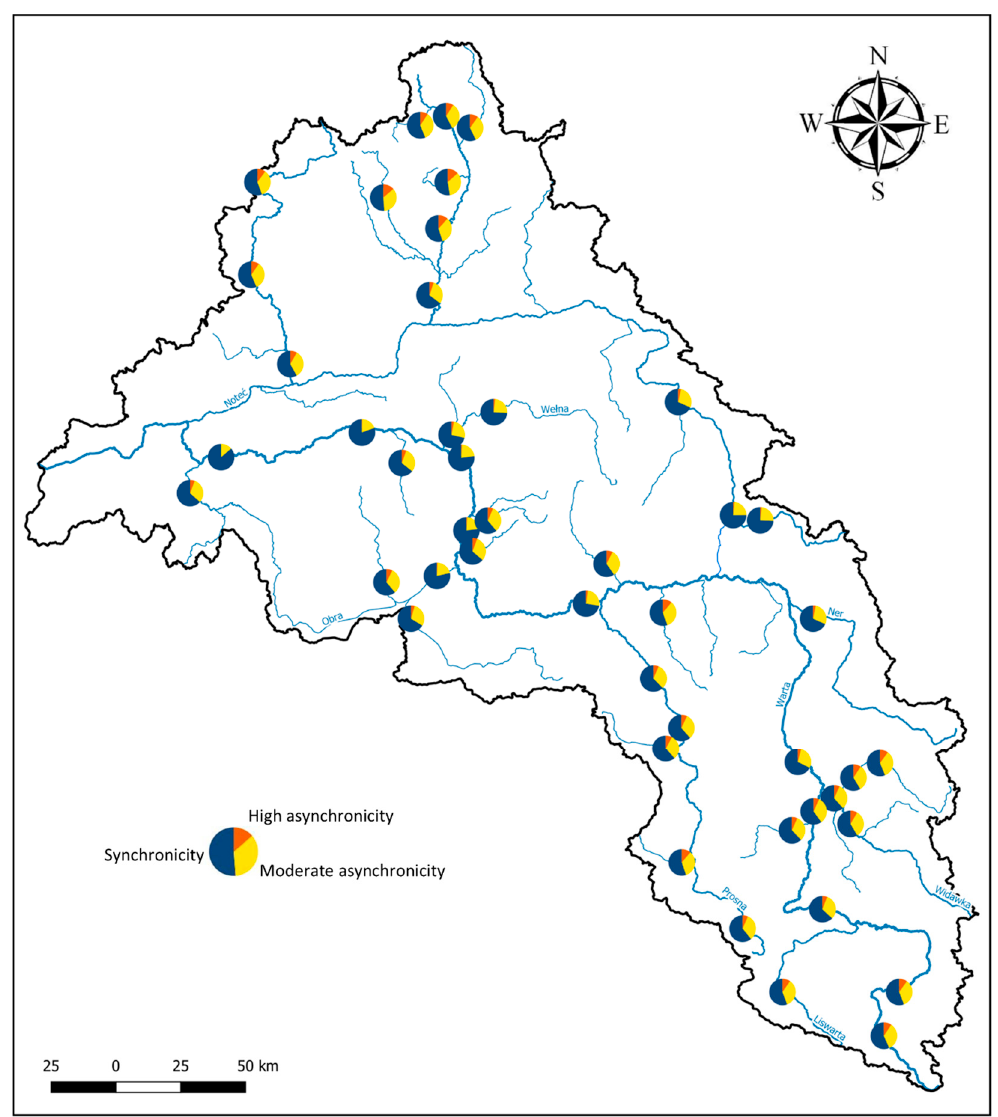
Figure 9. The pie charts showing the percent share of the synchronous and asynchronous occurrences of the summer maximum specific runoffs (SMAXq) in the Warta River catchment (WRC).